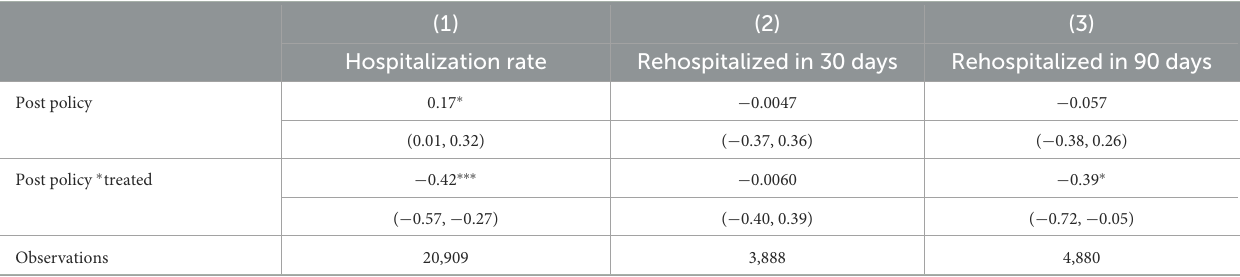
TABLE 7 DID regression analysis of the effect of policy change on health outcomes.